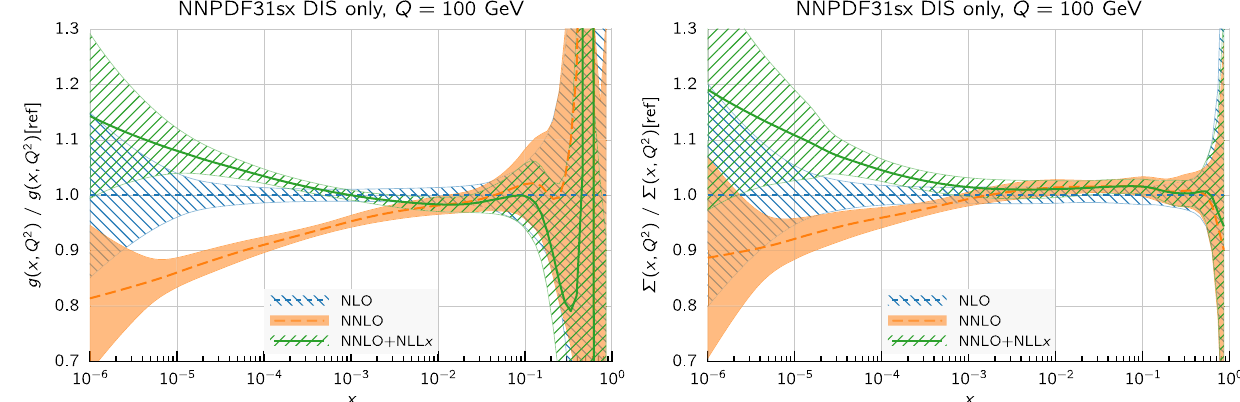
Fig. 9 Comparison between the gluon (left) and quark singlet (right plot) PDFs in the NNPDF3.1sx DIS-only fits using NLO, NNLO, and NNLO+NLL x theory at Q = 100 GeV, normalized to the central value of the former